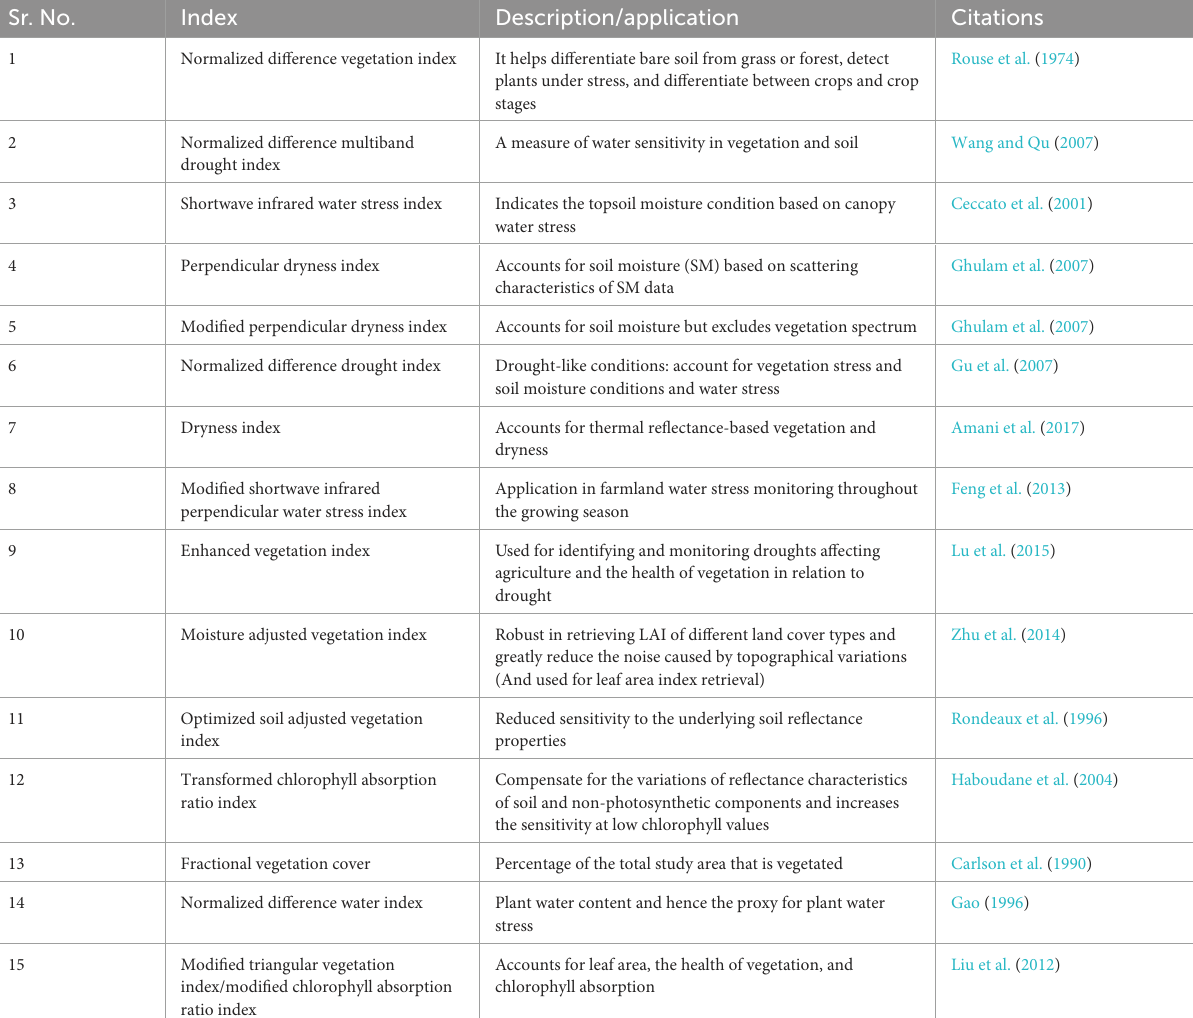
TABLE 1 Description and application of remote sensing indices to be used in the RSEI model. Sr.